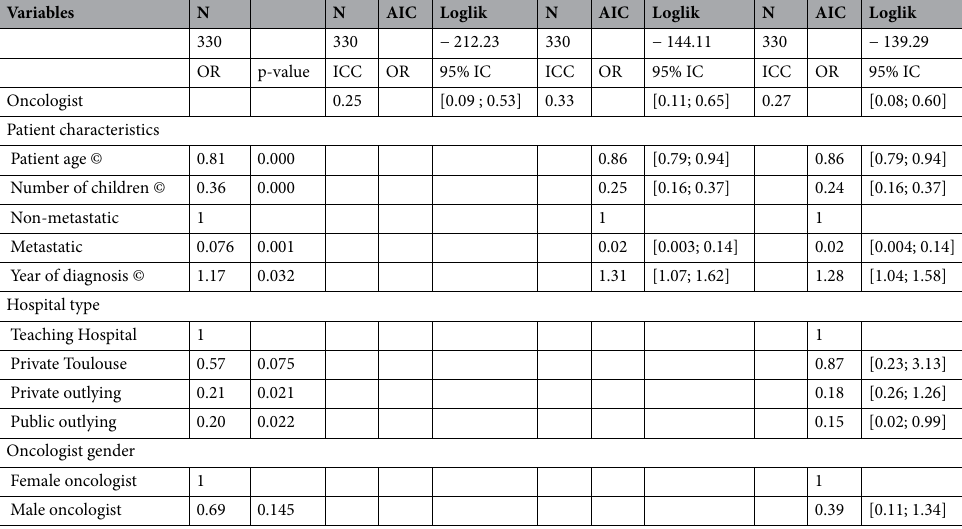
Table 3. Factors associated with having had an oncofertility consultation (multilevel analysis). N unweighted number of cases, © continuous variable, OR Odds ratio fixed effect, log lik log-likelihood ratio, AIC Akaike information criterion, ICC intraclass correlation coefficient, 95% IC 95% confidence